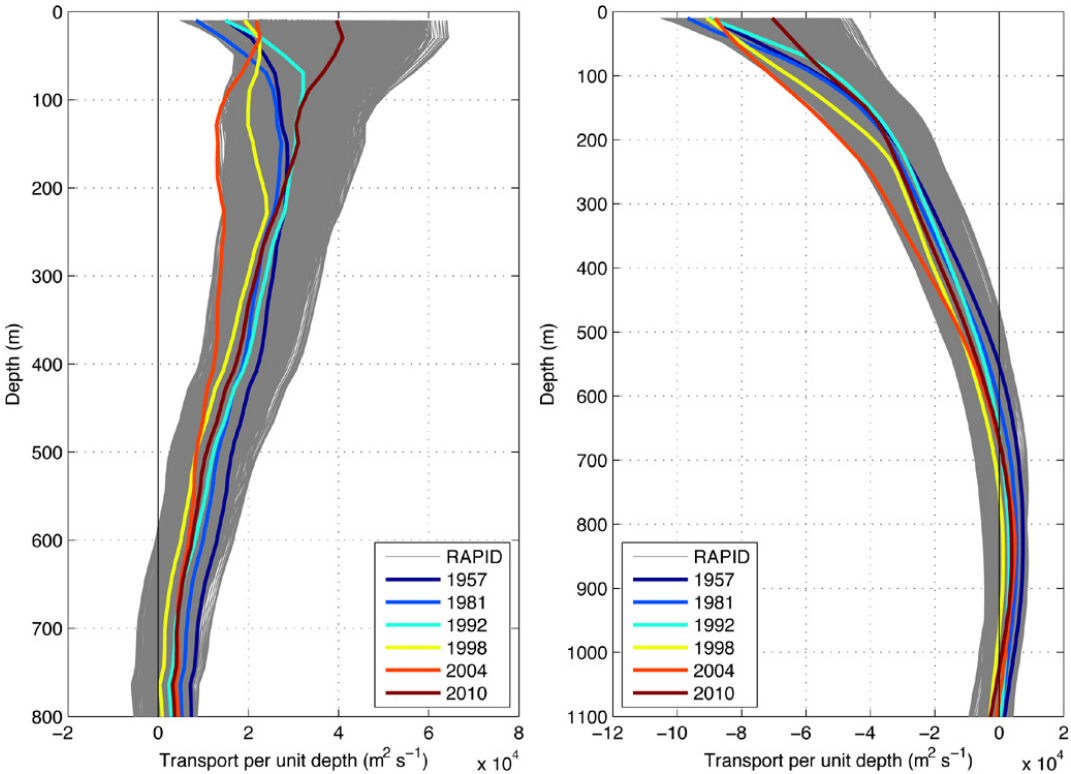
Fig. 6. Transport per unit depth profiles as for Fig. 5, but showing only the upper ocean. The left plot shows total upper ocean transport (excluding mean surface Ekman transport), the right plot shows mid-ocean transport (excluding mean surface Ekman transport and mean Florida Straits transport per unit